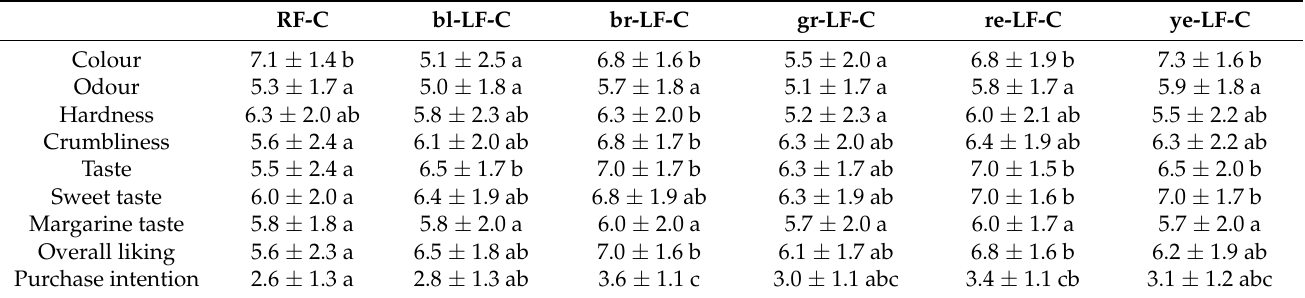
Table 11. Sensory properties of rice control and lentil cookies. RF-C: cookie made with rice flour, LF-C: cookie made with lentil flour, bl: black, br: brown, gr: green, re: red, ye: